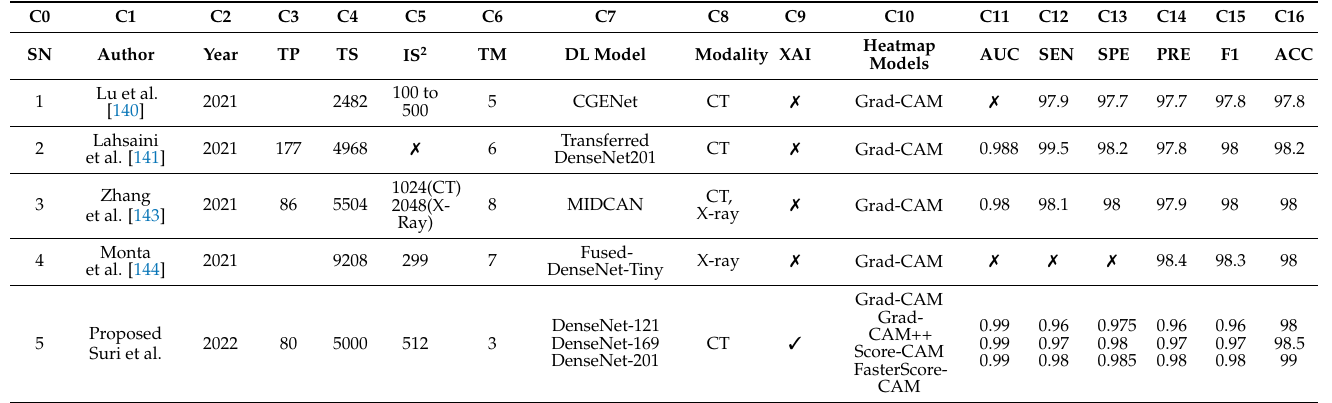
Table 4. Benchmarking